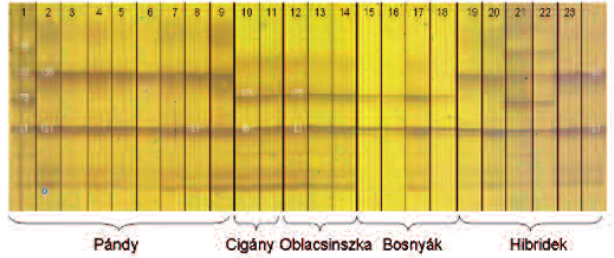
Figure 1. Silver stained microsatellite DNA profiles of the 24 investigated Hungarian sour cherry cultivars with primer pair PceGA25